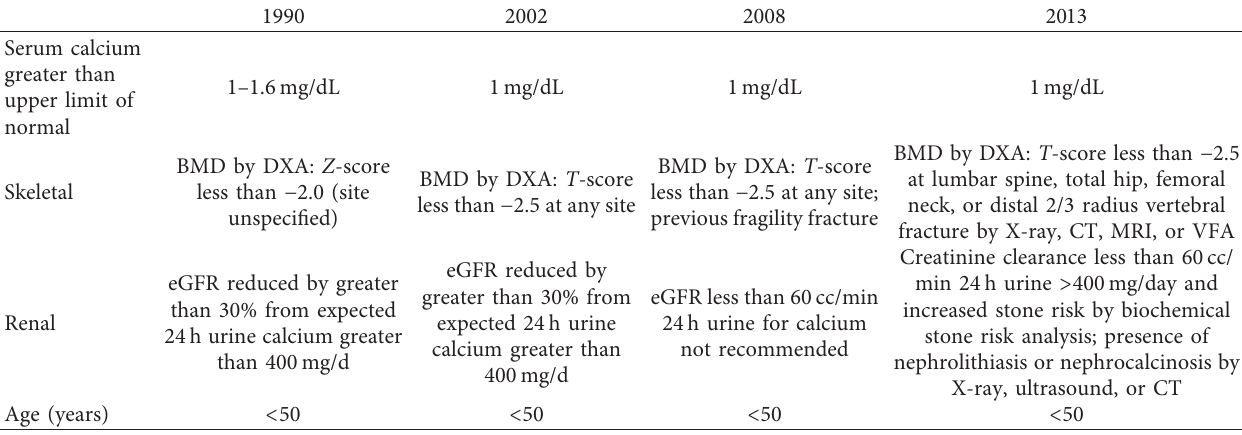
Table 1: Comparison of guidelines for surgery of asymptomatic HPT